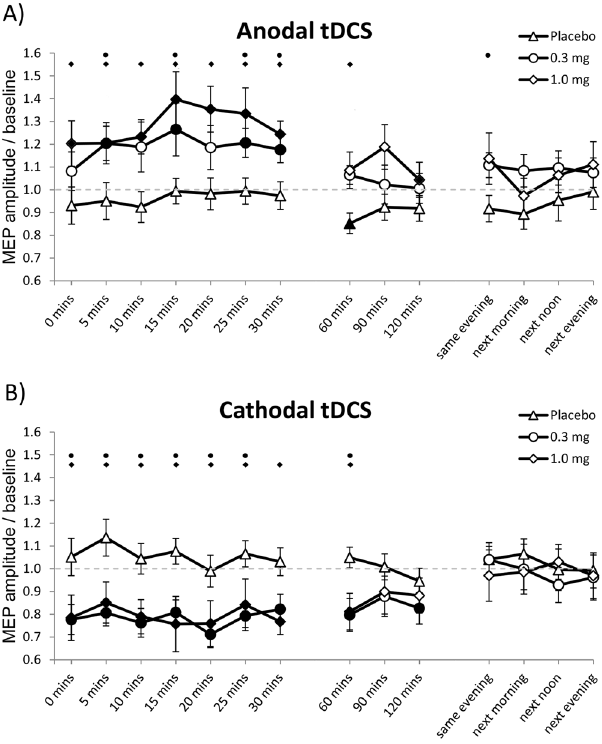
Figure 2. Impact of varenicline on tDCS-induced neuroplasticity. Shown are baseline-normalized MEP amplitudes after plasticity induction by anodal ( A ) and cathodal ( B ) tDCS under 0.3 mg, 1.0 mg varenicline or placebo medication conditions up to the evening of the post-stimulation day. ( A ) In smokers under placebo medication, anodal tDCS induced no excitability enhancement, while 0.3 mg and 1.0 mg varenicline resulted in enhanced MEP amplitudes after anodal tDCS. ( B ) In the placebo condition, cathodal tDCS failed to induce excitability alterations. In contrast, both low and high doses of varenicline led to significant inhibitory after- effects of tDCS. Error bars indicate S.E.M. Filled symbols indicate significant differences of post-stimulation MEP amplitudes from respective baseline values; Floating symbols indicate significant differences between the respective drug and placebo medication conditions at the same time points (Student’s t-test, two tailed, paired samples, p < 0.05).